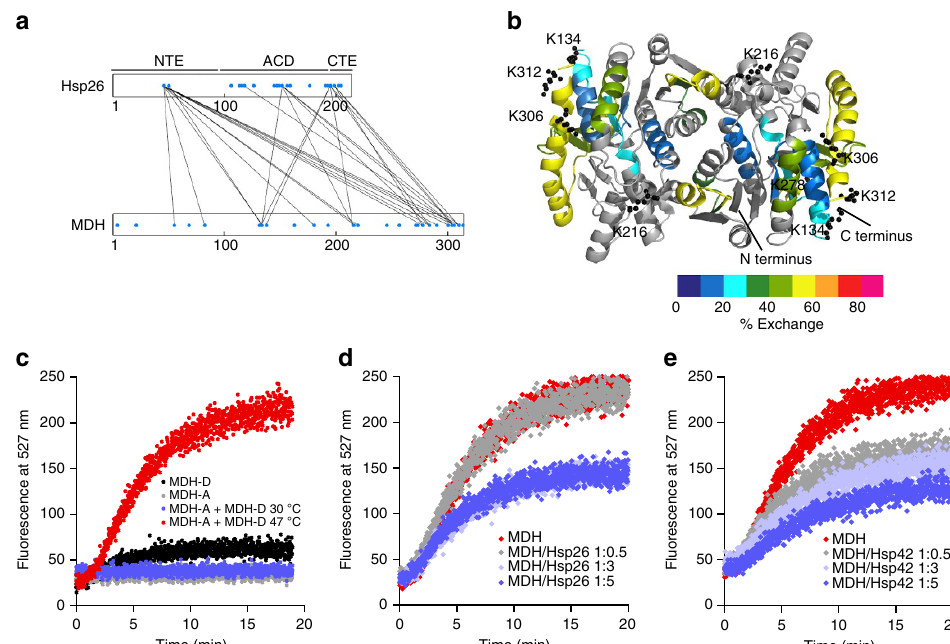
Figure 4 | Specific interactions of sHsps with MDH cause separation of sequestered MDH molecules. ( a ) Specific interactions of Hsp26 with exposed, flexible MDH segments. MDH–Hsp26 interaction sites were determined by DSS crosslinking and mass spectrometry analysis. Linear representation of crosslinks between lysine residues (blue dots) of Hsp26 and MDH. ( b ) HX-heat map of MDH from the heat-induced MDH/Hsp26 (1:5 ratio) complex. Peptic peptides are coloured according to their exchange behaviour (per cent exchange). Grey regions could not be identified. Lysine residues of MDH that were crosslinked to two or more lysines of Hsp26 are presented as balls and sticks. ( c ) Co-aggregation of MDH–YFP (FRETdonor) and MDH labelled with 7-diethylcoumarin-3-carboxylic acid (FRET acceptor) causes specific FRET increase at 47 (cid:2) C. Mixture of FRET donor and acceptor at 30 (cid:2) C and acceptor or donor only controls at 47 (cid:2) C do not result in FRET. Presence of Hsp26 ( d ) or Hsp42 ( e ) reduces FRET efficiencies between MDH–YFP